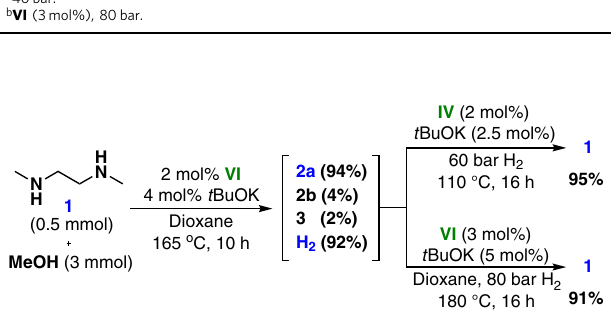
Fig. 2 Reversible interconversion between 1 /methanol and 2a by Mn- catalyzed hydrogenation and dehydrogenation.